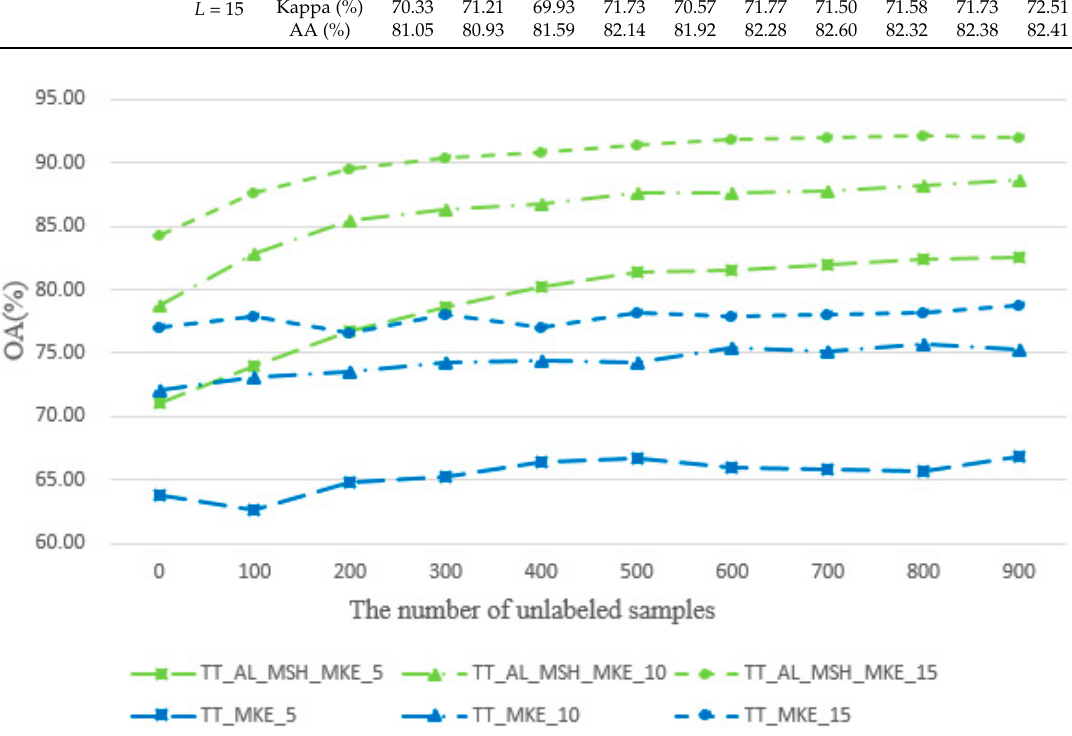
Figure 7. Overall classification accuracies obtained for the ROSIS Pavia University dataset using two different techniques by using 5, 10 and 15 labeled samples per class (estimated labels of unlabeled samples were used in all of the experiments).